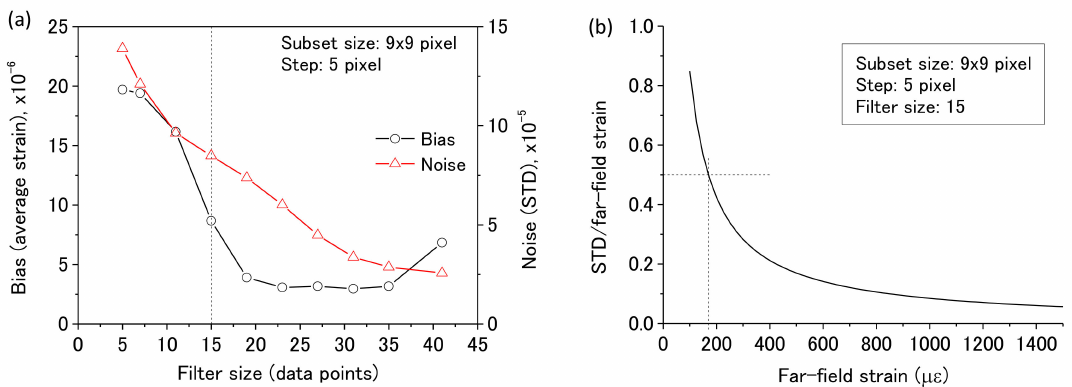
Figure 4. ( a ) Variation of strain measurement noise (standard deviation (STD)) and bias (average strain) with respect to the strain filter size; ( b ) evolution of noise-to-strain ratio, STD / far-field strain, with the far-field